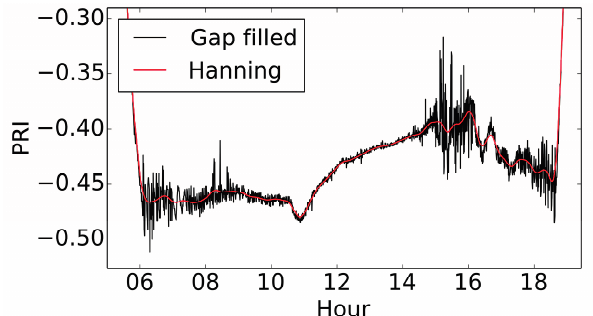
Figure 7. PRI signal shown for 8 May 2013. Times shown on the x -axis are in the Pacific Standard time